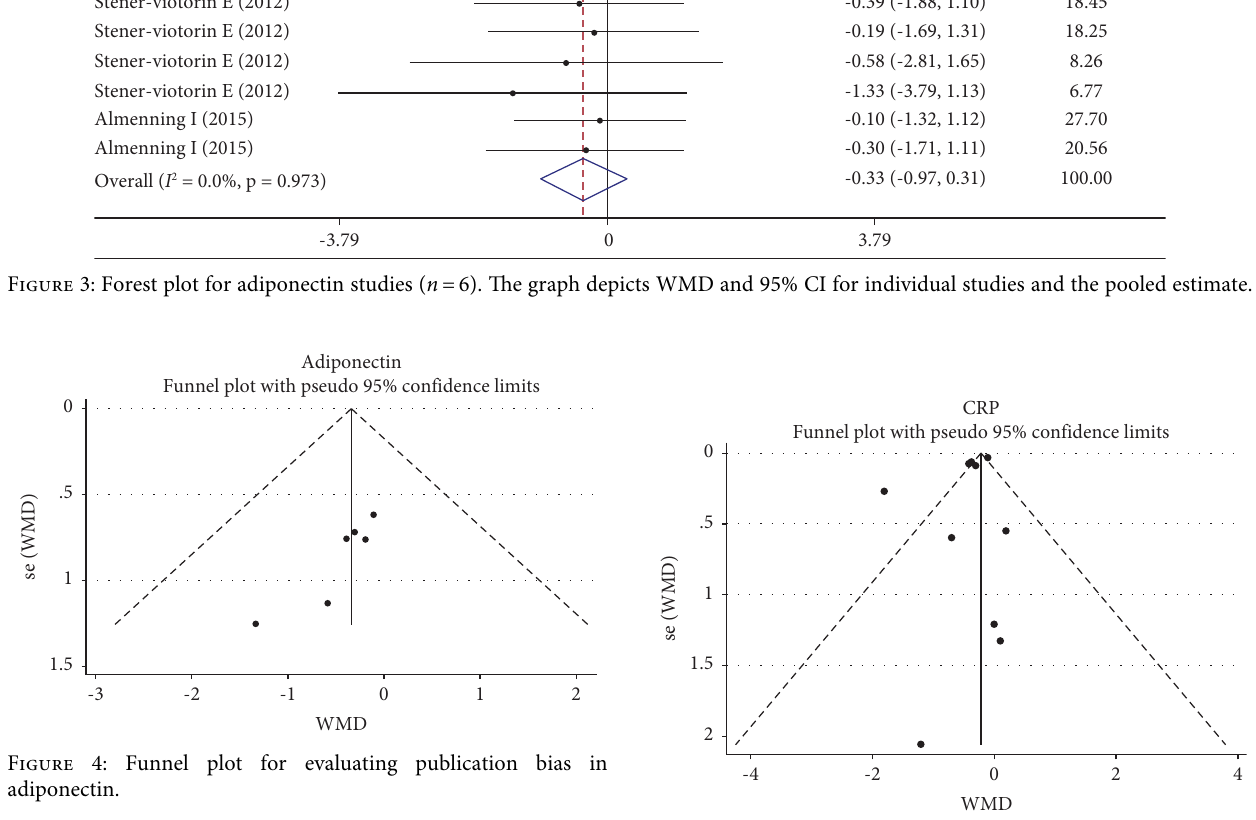
Figure 5: Funnel plot for evaluating publication bias in